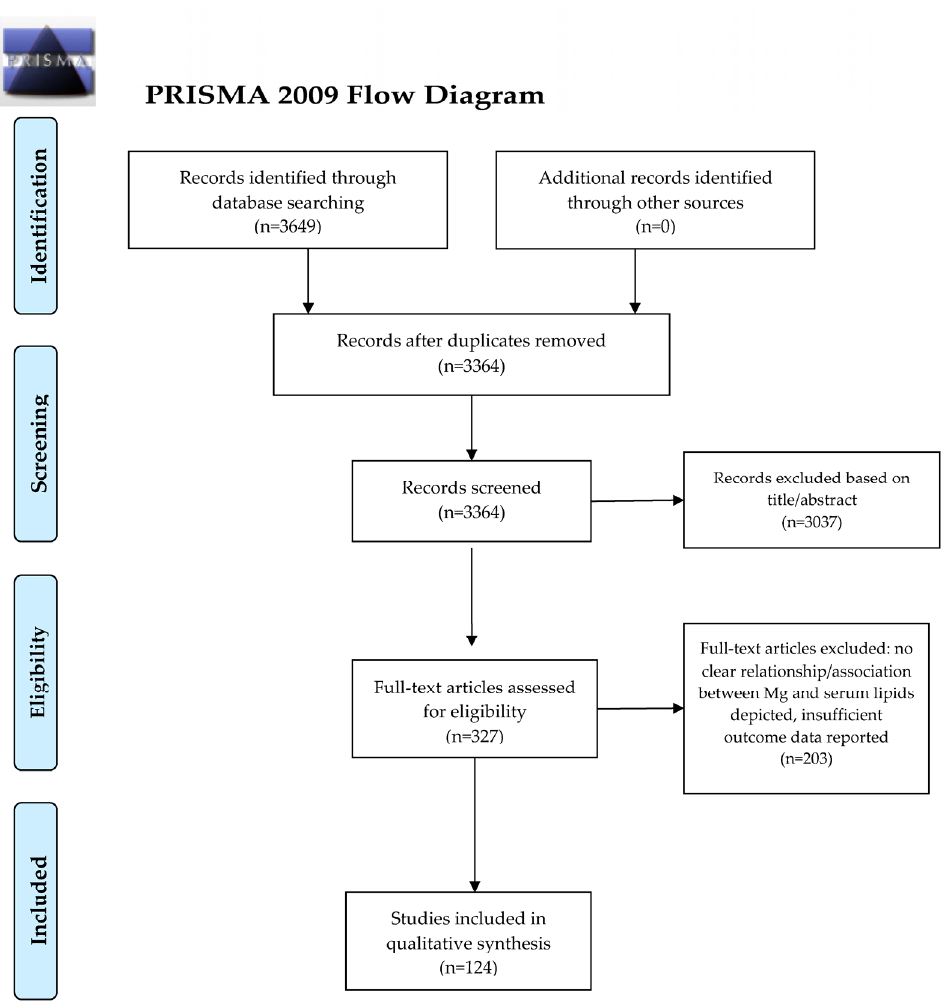
Figure 1. PRISMA 2009 Flow Diagram. From Moher, D.; Liberati, A.; Tetzlaff, J.; Altman, D.G. The Prisma Group. Preferred reporting items for systematic reviews and meta-analyses: The PRISMA statement. PLoS Med . 2009 , 6 , e1000097, doi:10.1371/journal.pmed.1000097. For more information, visit www.prisma-statement.org (accessed on 18 March 2021)